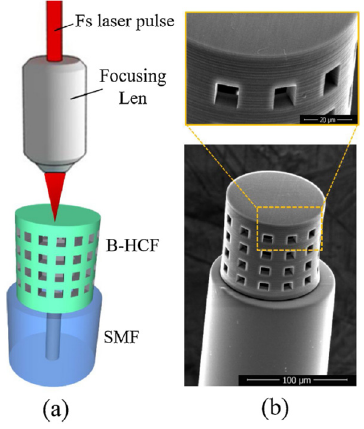
Figure 37. Point sensor. ( a ) Schematic diagram; and ( b ) scanning electron microscope image of the “castle style” FPI microcavity. Reprinted with permission from [196] © Elsevier . “castle style” FPI microcavity. Reprinted with permission from ref. [196]. Copyright 2021 Elsevier